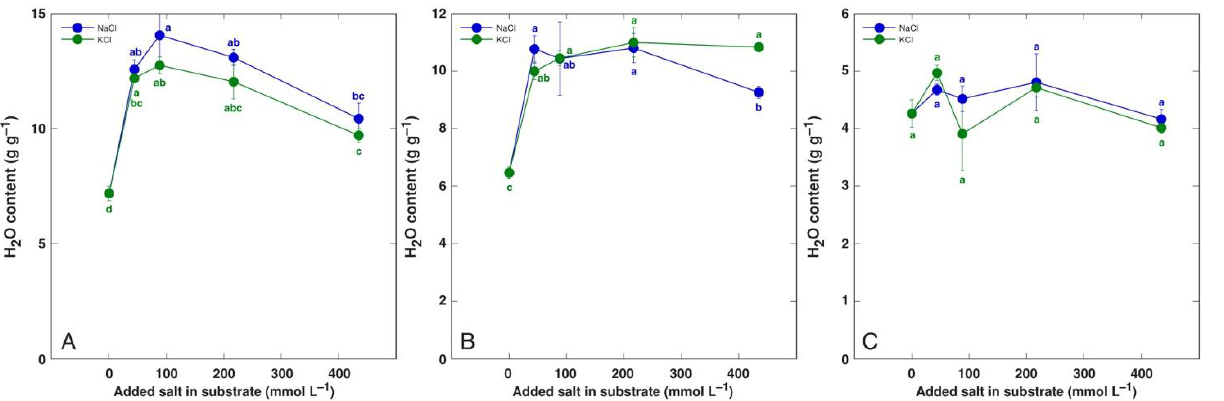
Figure 4. Tissue water content of old leaves ( A ), young leaves ( B ), and roots ( C ) of Beta vulgaris subsp. maritima plants cultivated in soil and treated with different doses of NaCl and KCl. Different letters indicate statistically significant ( p < 0.05) differences between treatments. Figure is taken from Ievinsh et al., 2022 [184].